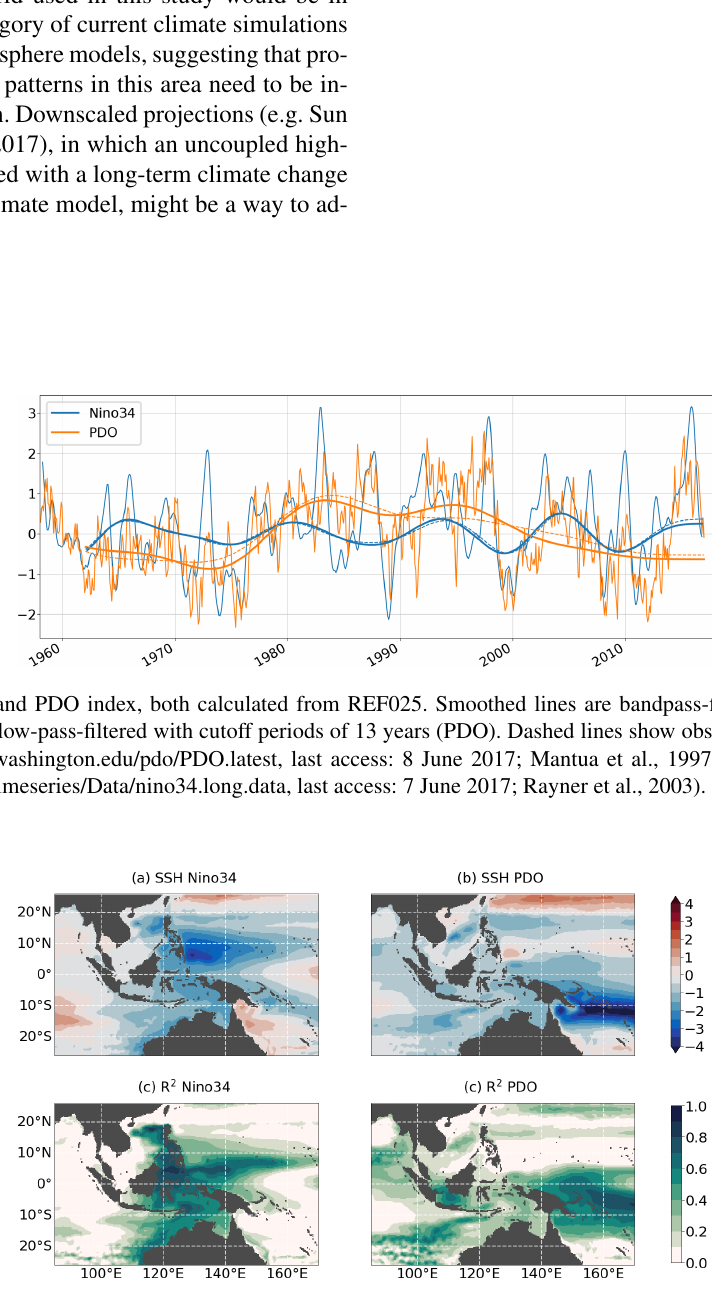
Figure A2. Linear regression of SSH from WIND on the (a) Niño3.4 and (b) PDO index as well as the (c, d) respective coefficients of determination. Both climate indices are derived from REF025. All data were filtered with an 8-year low-pass